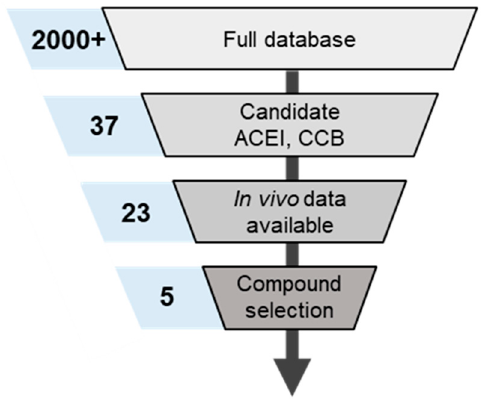
Figure 5. Metrics for candidate compound identification unitilizing internal database of small molecule PK. The numbers in blue boxes correspond to the number of compounds identified as acceptable during each stage of curatrion.